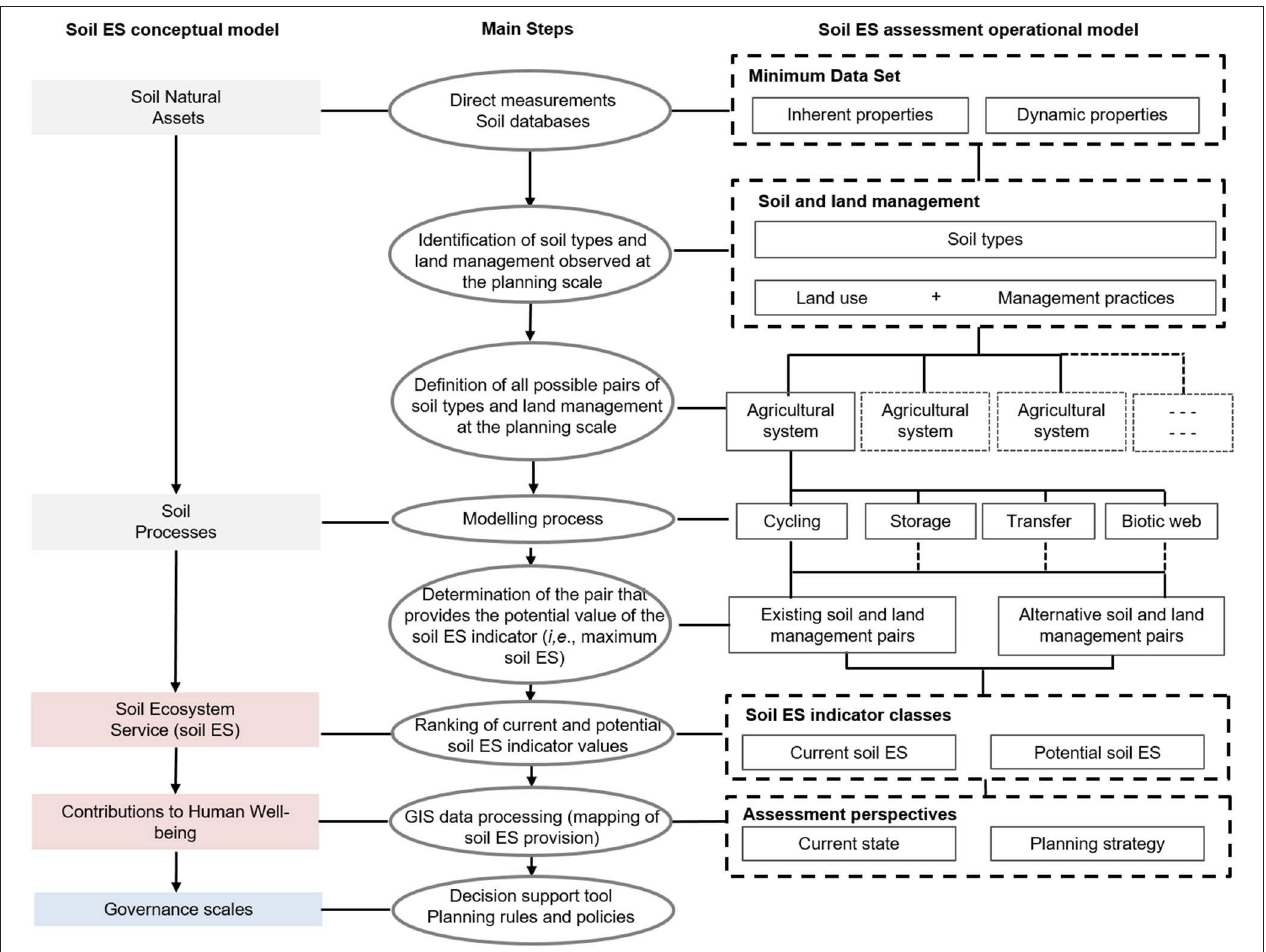
FIGURE 3 | Workflow of the operational model for assessing agricultural soil ecosystem services